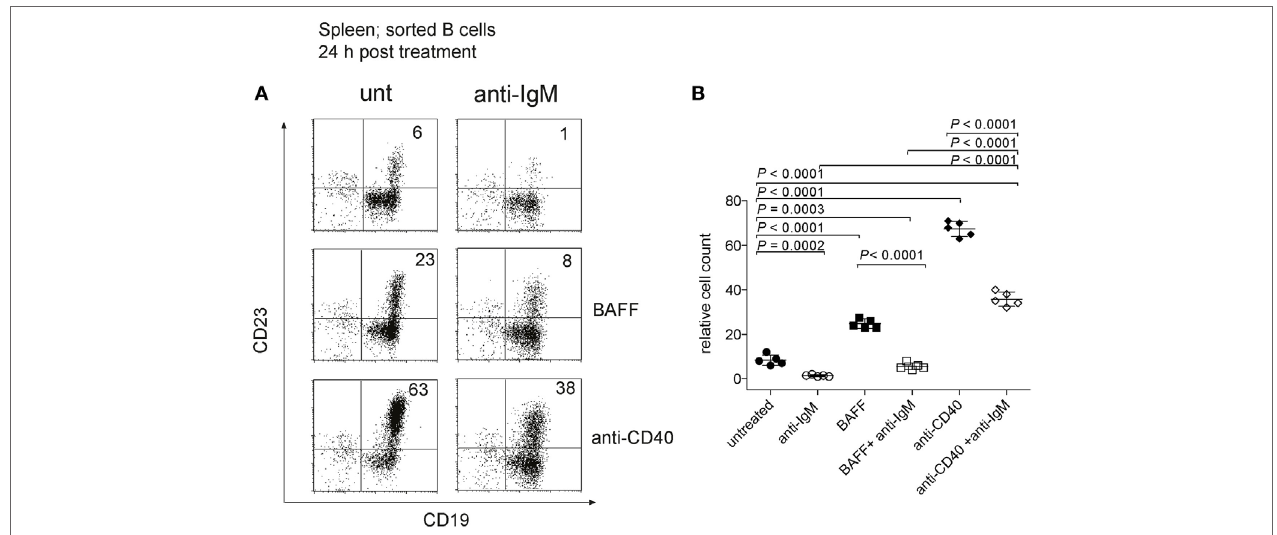
FigUre 6 | Anti-IgM treatment of transitional 1 (T1) B cells in vitro. (a) To obtain T1-B cells, imb-1-derived splenocytes were sorted at day 6 post induction using CD43 and Thy1.2 antibodies to exclude non-B cells. Identical cell numbers were cultured in vitro in the absence or presence of anti-IgM (10 µg/ml) and/or human recombinant B cell activating factor (BAFF) (75 ng/ml) and anti-CD40 antibodies (10 µg/ml) for 24 h. Expression of CD19 and CD23 is shown. The cells were stained with 7AAD to exclude dead cells and only viable 7AAD cells were included in the analysis. The numbers in quadrants indicate relative cell numbers acquired after analysis of 10 5 total events per sample. Representative data from three independent experiments with two duplicates for each treatment are shown. (B) Quantification of relative cell numbers form the experiment depicted in (a) . Stimuli are indicated in the graph. P values were obtained using a two-tailed Student’s t -test and are indicated; Mean ± SD values are indicated for n = 5. Each dot represents an individual